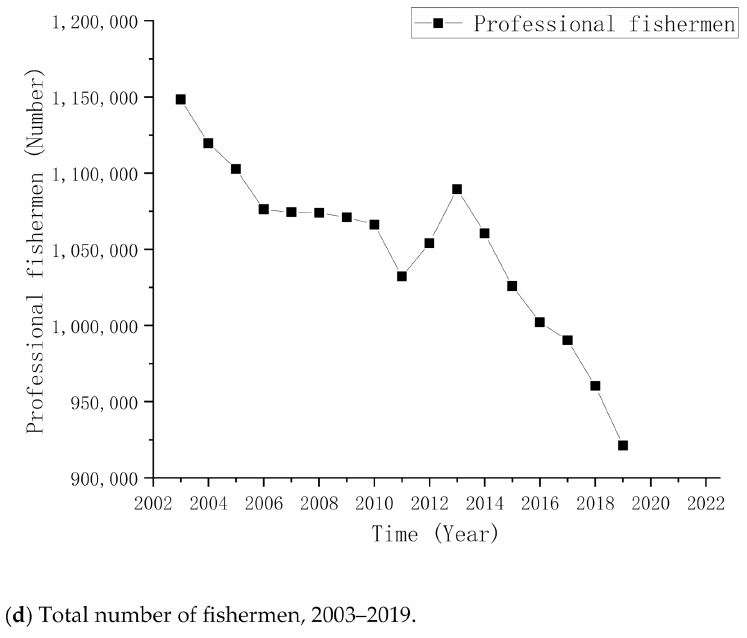
Figure 2. Four factors fluctuating in China’s offshore fisheries from 2003 to